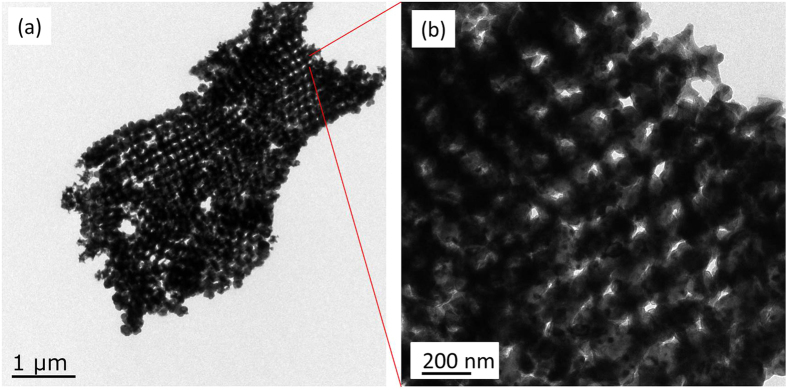
TEM images of Mn2O3/Al membrane with aluminizing time of 20 min.